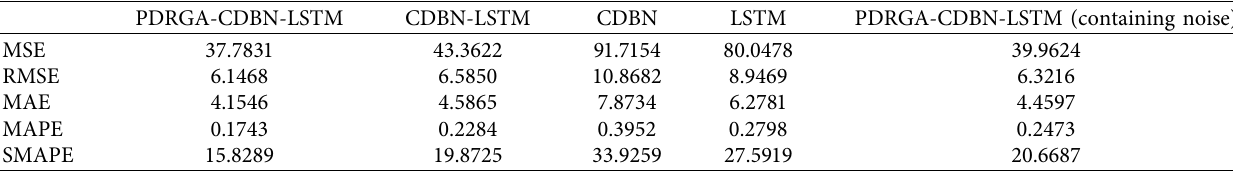
Table 5: Error evaluation indicator of each model using the Hefei demonstration zone ITS dataset.